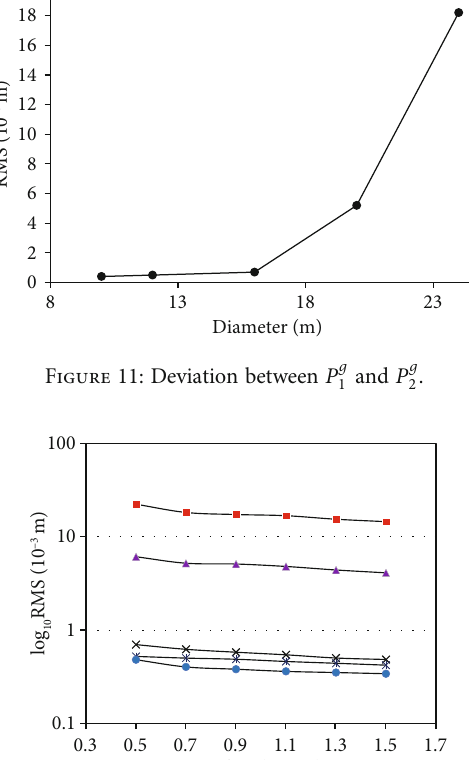
Figure 12: E ff ect of the cable